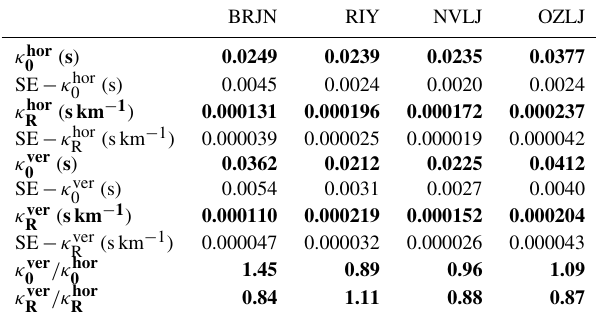
Table 2. Summarized results of errors-in-variables regression (fol- lowing the method by York et al., 2004) for κ − R e depen- dence based on horizontal- and vertical-component κ models ( κ hor and κ ver ) using the AH84 model. Site-specific (near-site) attenu- ation values κ hor and κ ver , slopes of regression in terms of κ hor 0 0 and κ ver , standard errors for intercepts, and slopes and ratios of R κ ver /κ hor /κ hor and κ ver are listed for each seismological station. R R 0 0 Standard errors (SEs) for the intercept and slope are also listed (not bolded).